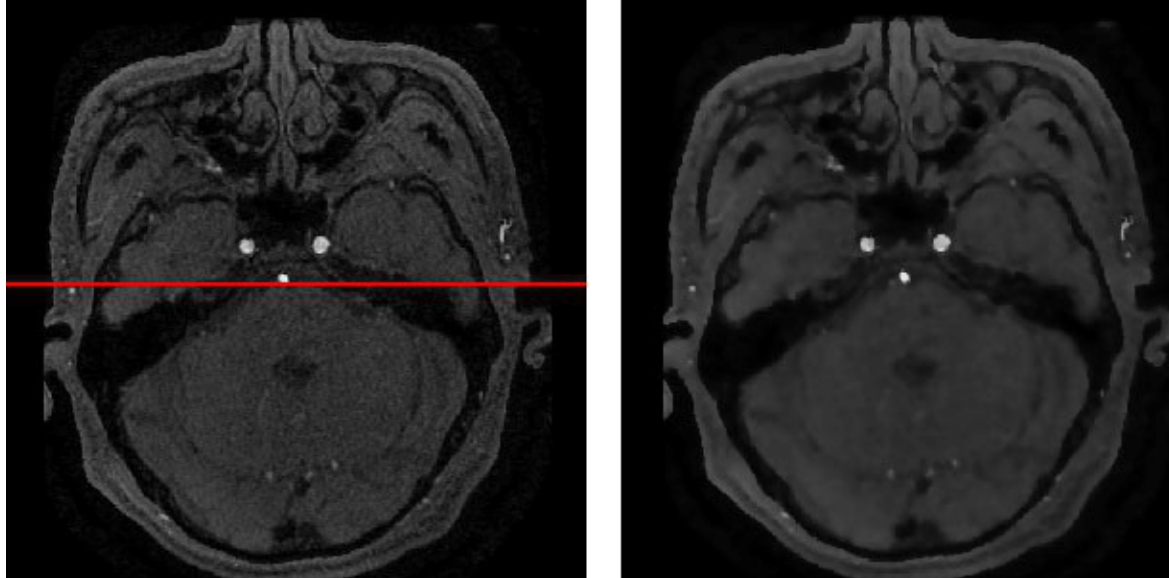
Figure 5. Level noise reduction. Left: Original image; right: Anisotropic diffusion